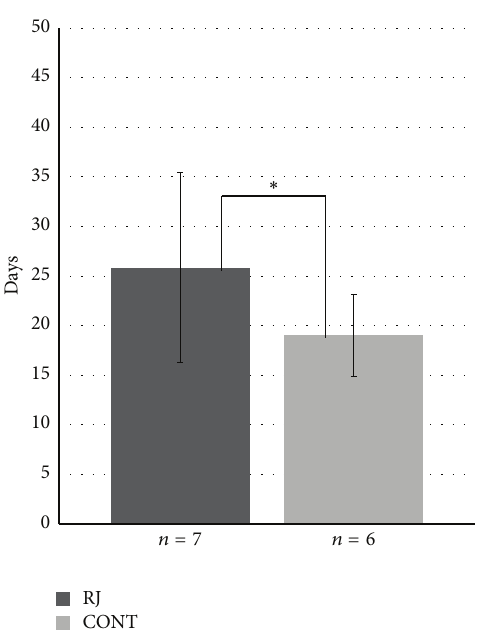
Figure 3: Time to progress to G3 mucositis. Each data point represents the mean ± SD. Mann-Whitney 𝑈 test: ∗ 𝑃 < 0.001 versus